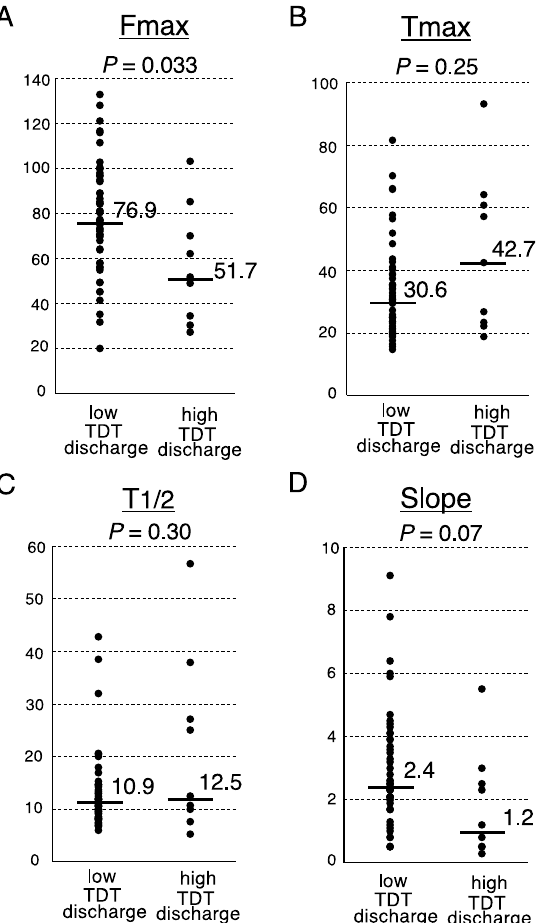
Figure 2. Analysis of the ICG fluorescence-related parameters according to the TDT discharge volume. Fmax ( A ), Tmax ( B ), T1/2 ( C ) and Slope ( D ). Medians, bars. Mann-Whitney U